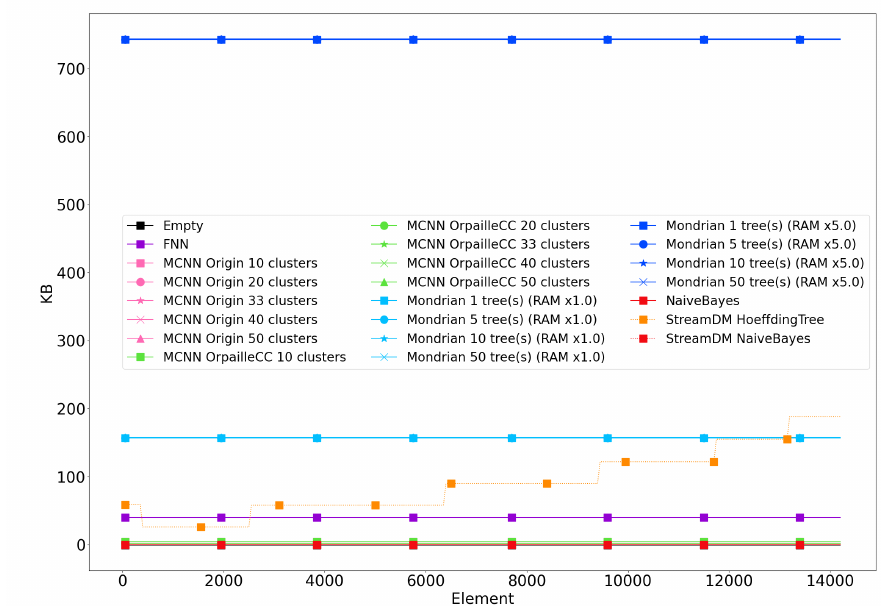
Figure 3. Memory footprint of classifiers with the empty classifier as a baseline, measured on the Banos et al. dataset. The memory footprint of the empty classifier is 3.44 MB. The baselines are the two Naïve Bayes from OrpailleCC and StreamDM-C++. Their respective memory footprints are 3.44 MB and 4.74 MB.